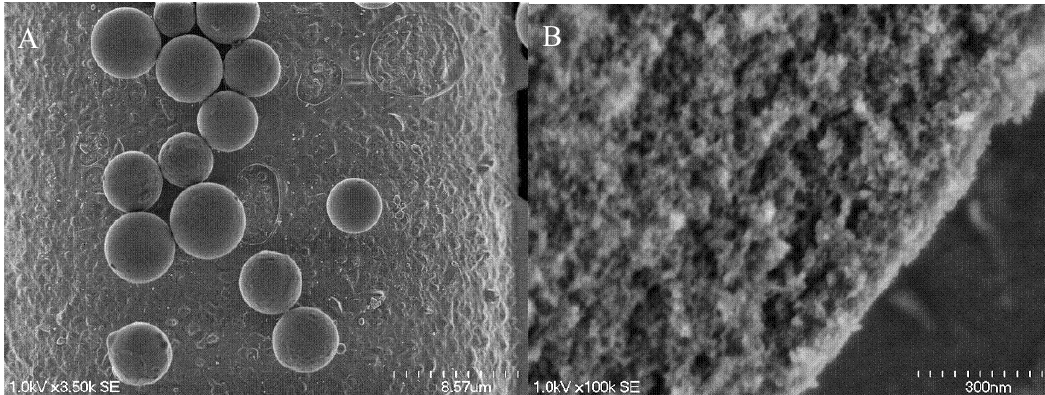
Figure 2. Images of solid and porous microspheres. (A) Scanning EM image of a non- porous microsphere with an average diameter of ~ 5 μ m, and (B) high resolution transmission EM image of a porous microsphere showing the porous surface. A